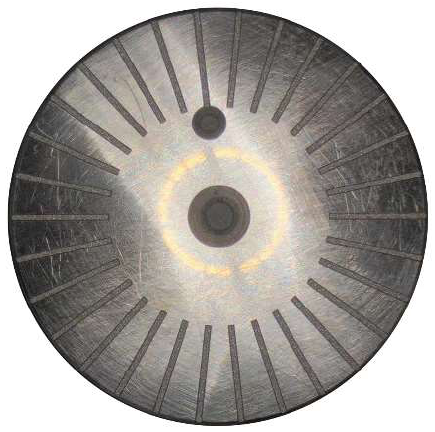
Figure 2. Electric-spark texture.